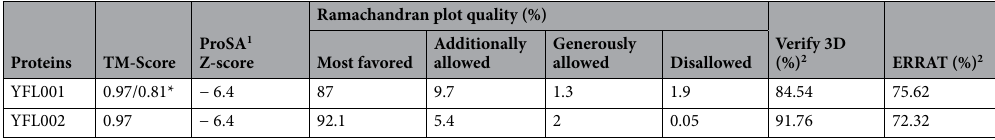
Table 1. Structural validation of predicted models. 1 ProSA Z-score determines the overall model quality. 2 100 is the best and 0 is the worst. *TM-scores of the pairwise structural comparison of YFL001 fragment towards the templates (VH-VL compared to 6CYF.LM and mCH3cc compared to 5HSF.A, respectively).